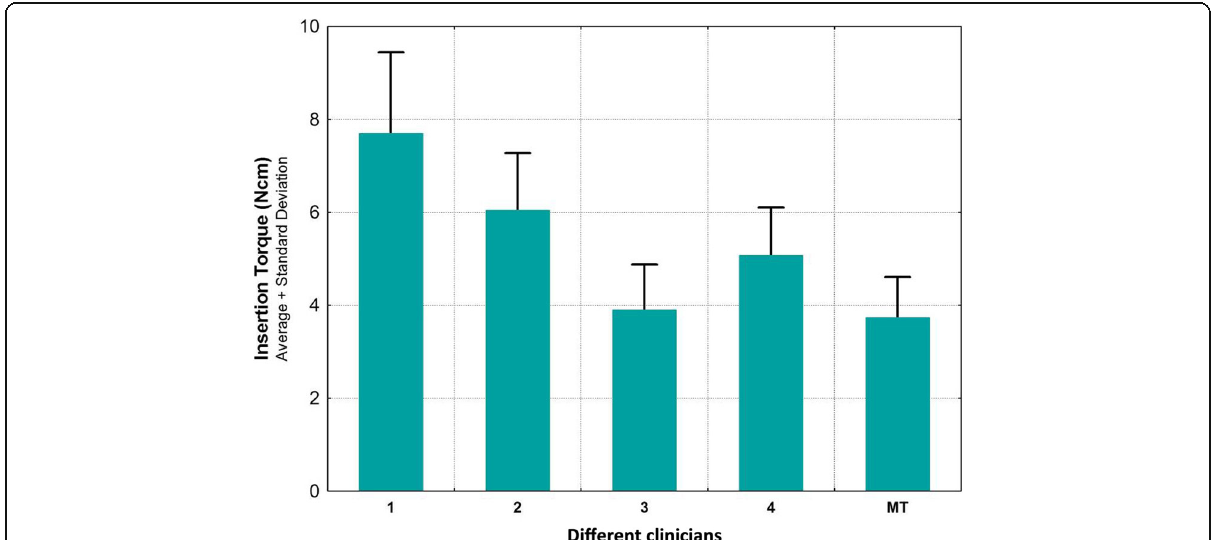
Fig. 3 Frequency distribution among test group (hand-tightened SmartPegs by examiners 1 to 4) and control group (MT = mechanically inserted SmartPegs) according to insertion